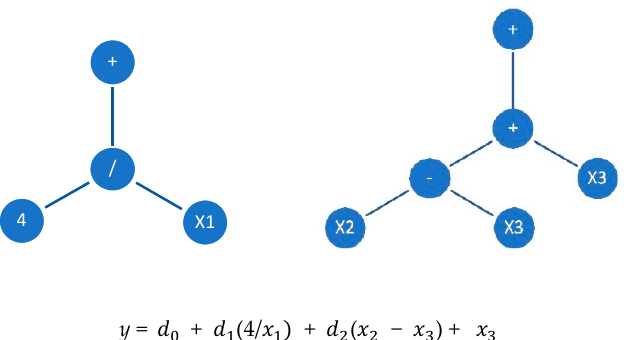
Figure 1. A typical multi-gene GP model.